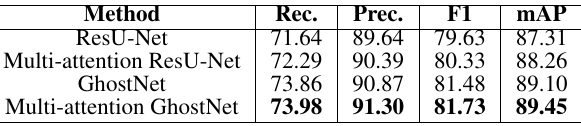
Table 3. Metrics results, in [%], for the four methods